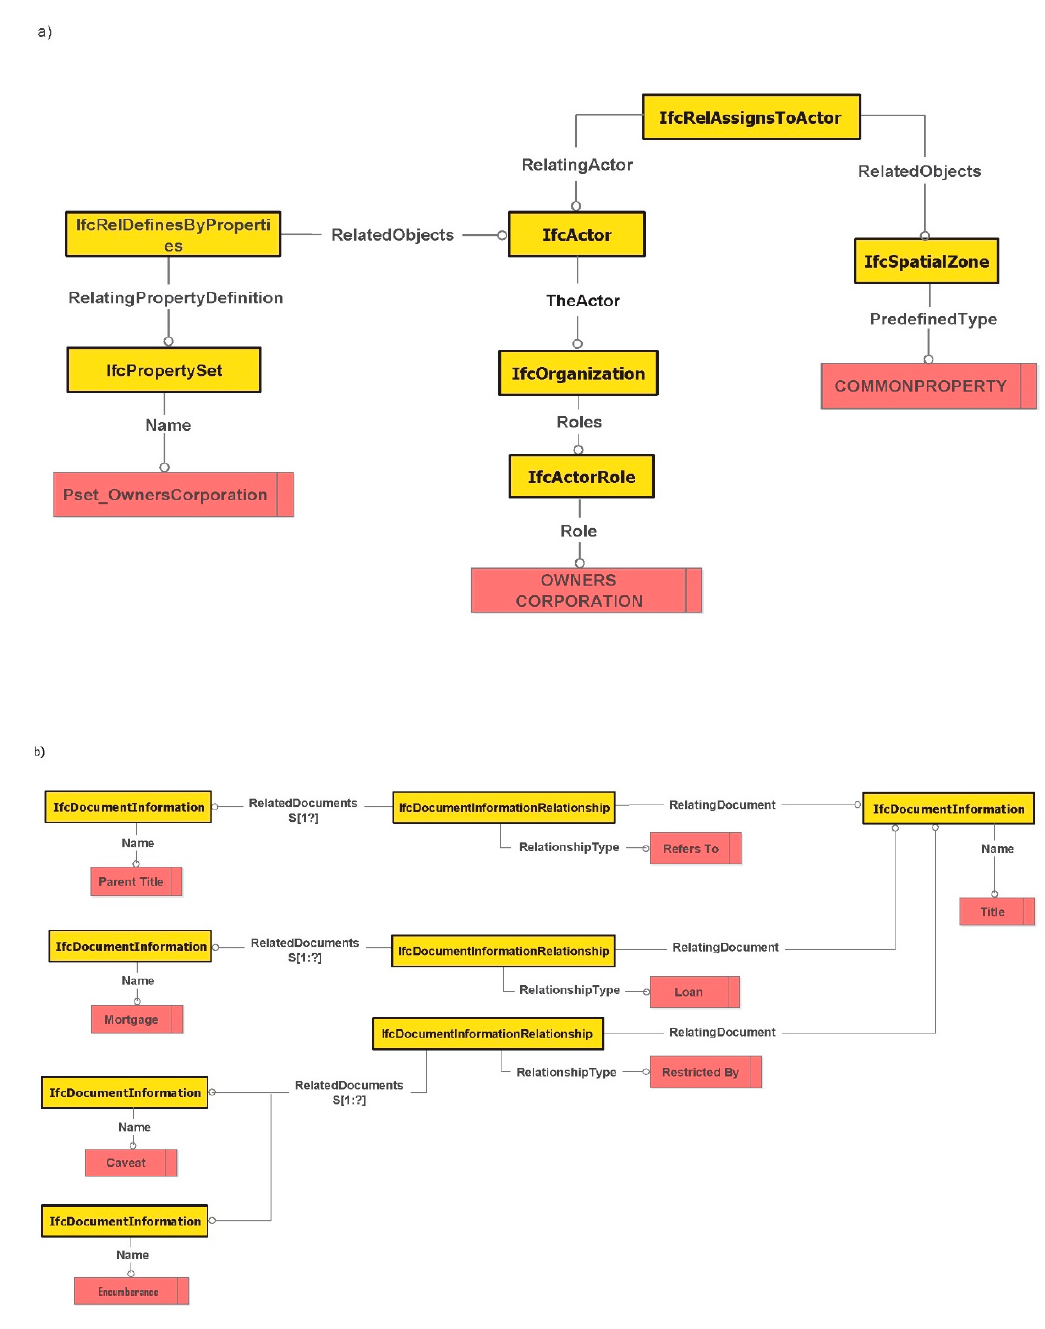
Figure 8. ( a ) Assigning Owners Corporation to common property ( b ) Modelling legal documents used in the registration phase within the Industry Foundation Classes (IFC) standard.